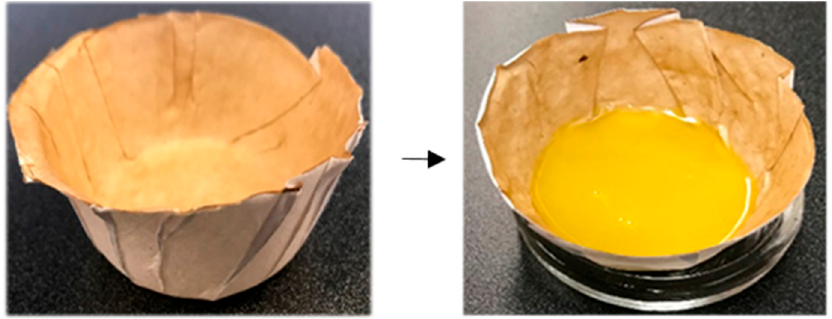
Figure 7. Photographs of LCNF-coated papers formed into a bowl-like shape with the capability to hold vegetable oil after five months.